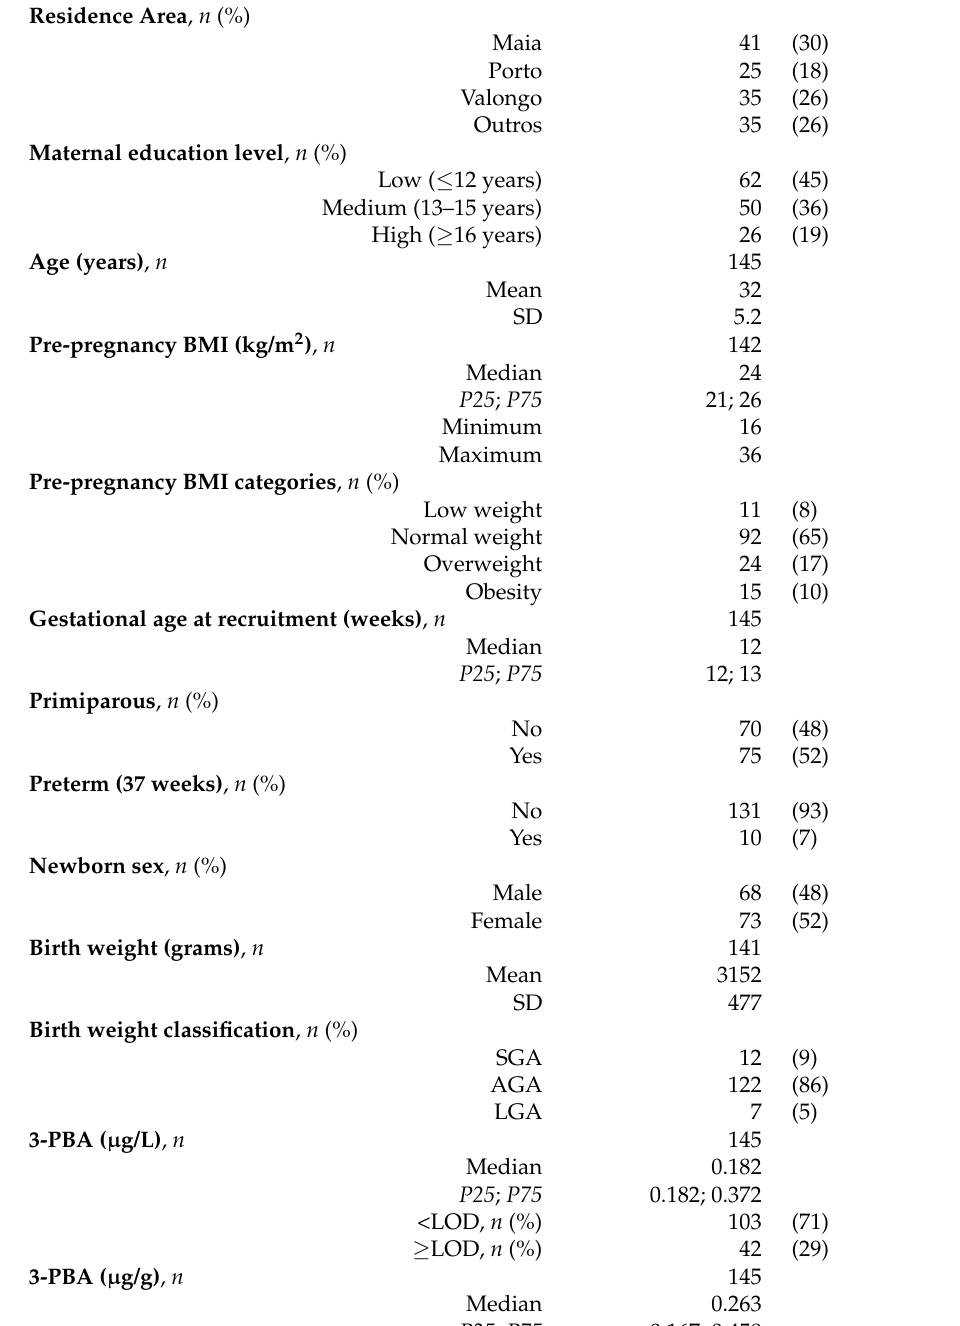
Table 1. General characteristics of the study sample ( n = 145).